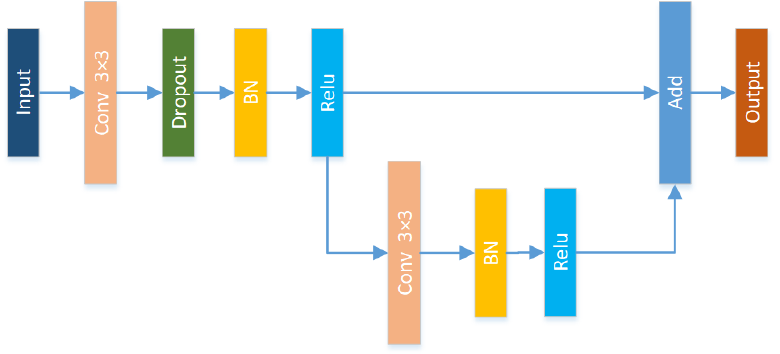
Figure 6. Res-Block structure: each convolution process includes three processes: dropout, BN, and